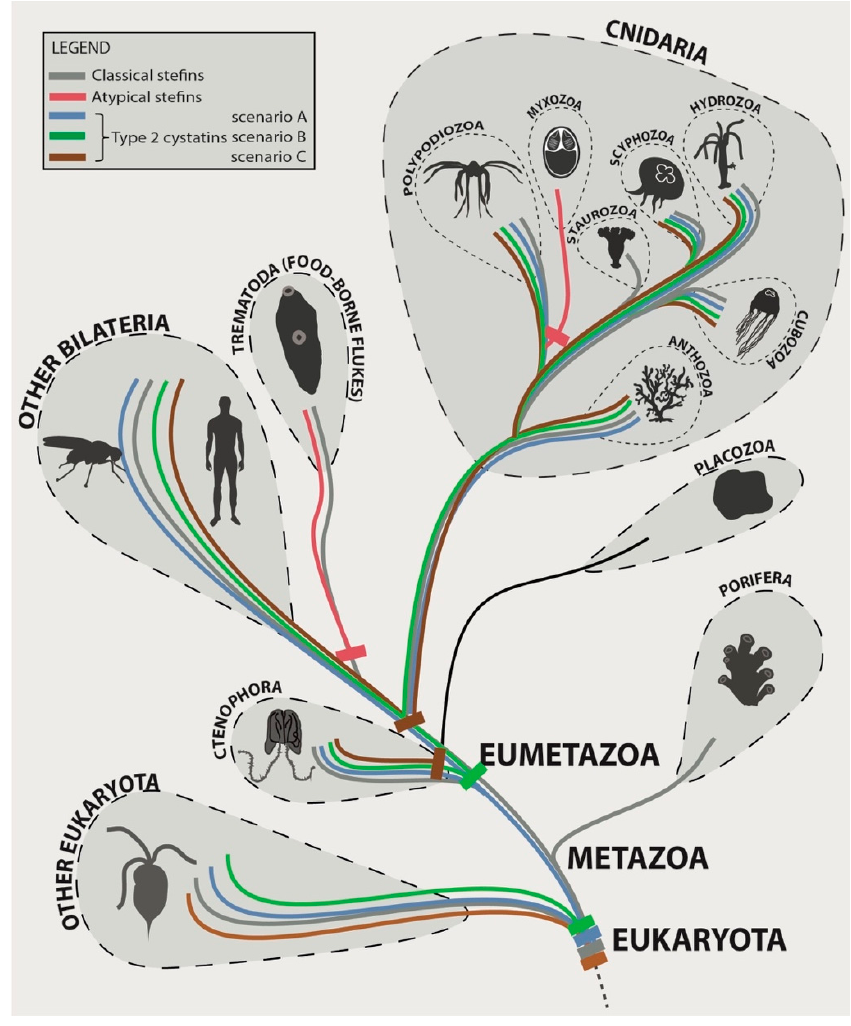
Figure 4. Hypothetical evolutionary scenarios of origins of stefins and type 2 cystatins in the Metazoa with a focus on early-emerging animal lineages: please note that the different colors for type 2 cystatins visualize the alternative scenarios of hypothetical evolution for the same cystatin subtype and not the sequence differences.